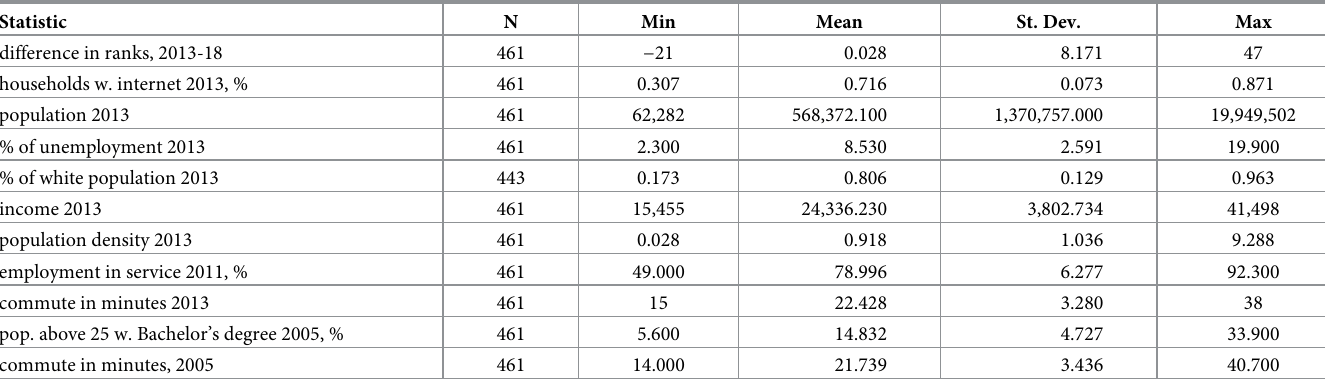
Table 6. Descriptive statistics for the USA